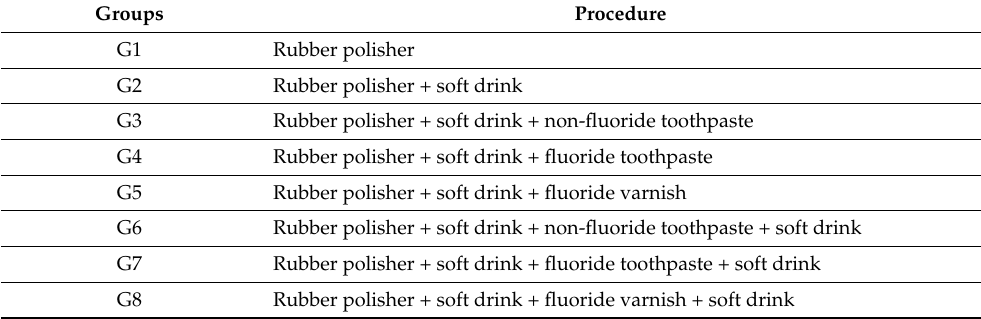
Table 1. Groups divided by surface treatment.